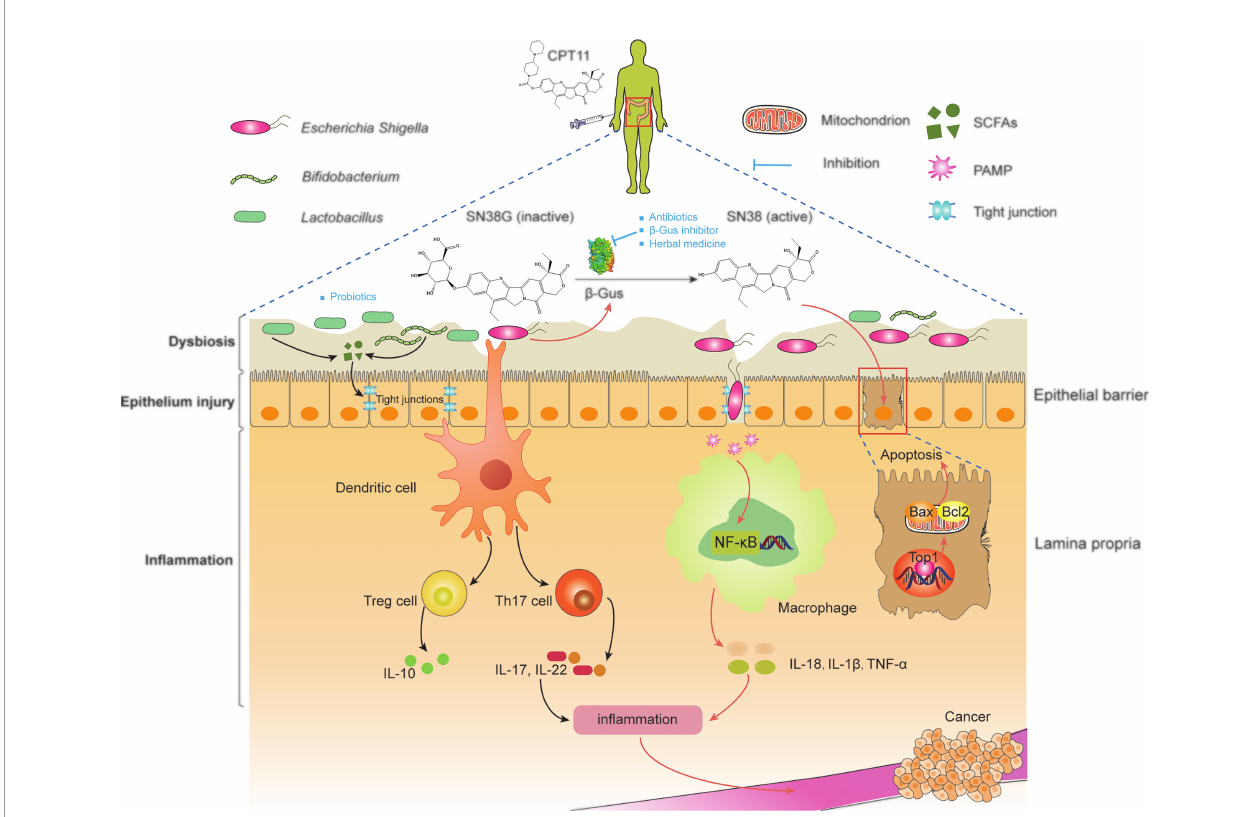
FIGURE 3 | Manipulation of microbiota improve the outcomes of CPT11 chemotherapy. SN38 active), regenerated by microbial b -glucuronidases in the intestinal tract from SN38G (inactive), primarily targets topoisomerase 1, thereby causing breaks in DNA strands. SN38-induced DNA lesions lead to the apoptosis of intestinal epithelial cells, which destroys the epithelial barrier. Then, local in fl ammation and dysbiosis are triggered. In addition, shortening of intestinal villi and bacterial translocation can amplify this damage, and lead eventually to CPT11-induced diarrhea. Moreover, microbial dysbiosis can affect the development and progression of cancer by activating in fl ammatory signaling pathways. Antibiotics, b -glucuronidase inhibitors, and herbal medicines can be used to inhibit b -glucuronidases to alleviate intestinal symptoms. Probiotics mediate microbial metabolism and immunologic homeostasis by reconstruction of the intestinal microbiota, thereby synergizing with CPT11 chemotherapy. SCFAs, short-chain fatty acids; PAMP, pathogen-associated molecular patterns; IL-10, interleukin 10; TNF, tumor necrosis factor; b -Gus, b -glucuronidases; Th17, T helper 17; Top1, Topoisomerase I; NF- k B, nuclear factor-kappa B; Bax, BCL2-associated X; Bcl2, BCL2 apoptosis regulator.